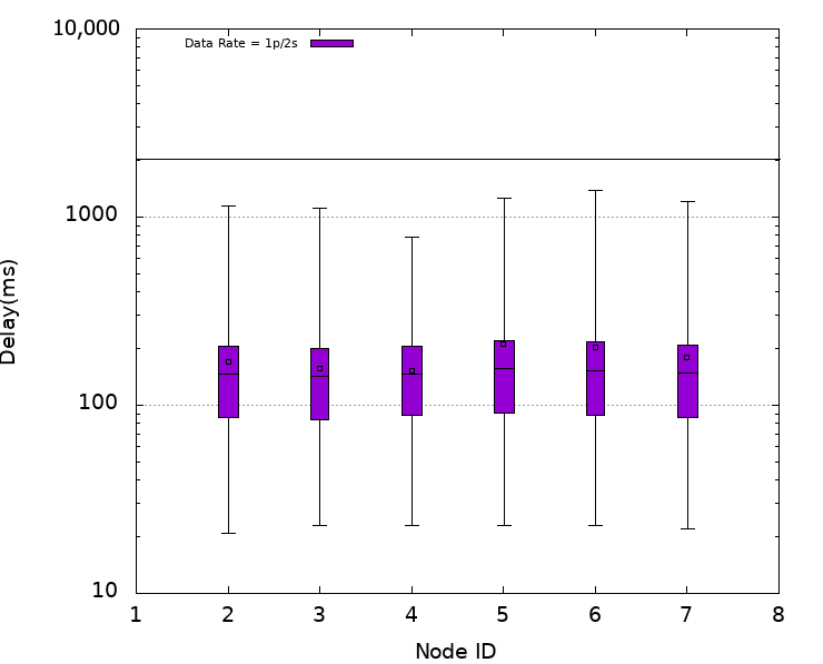
Figure 9. TSCH/TASA delay